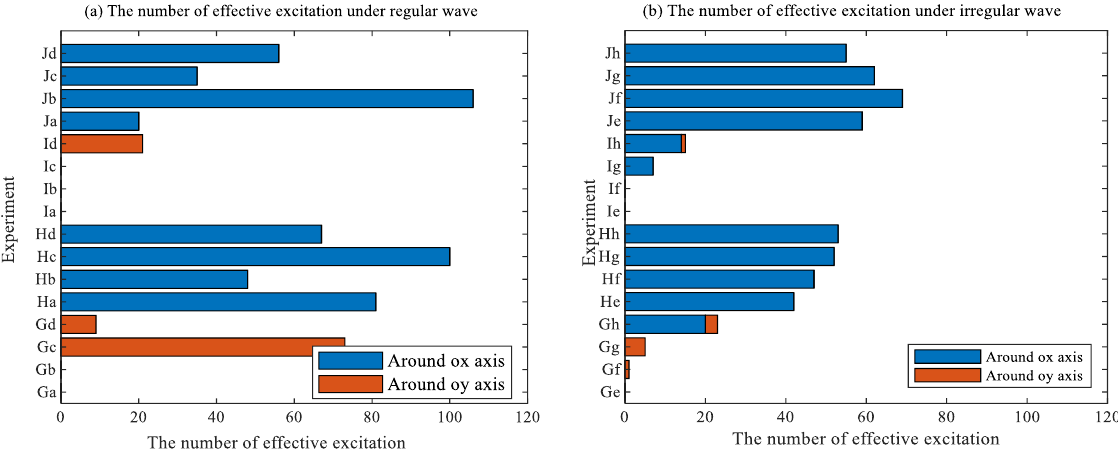
Figure 17. The number of effective excitations in the three-anchor line mooring mode.